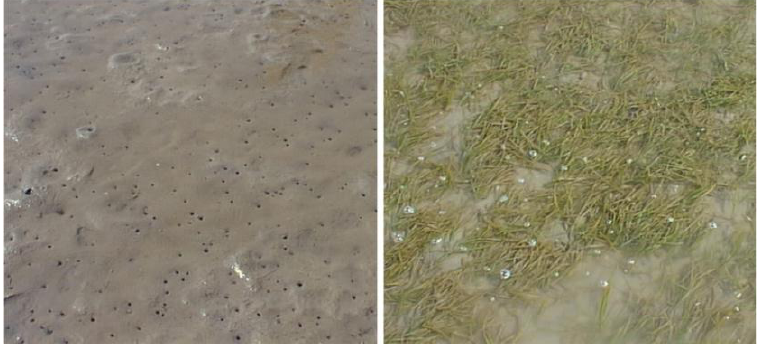
Figure 5. Comparison of a bare tidal flat ( left ) and an adjacent area colonized by seagrass Zostera noltii ( right ) in the Venice lagoon (Italy). (Photo credit: MeLA2 project